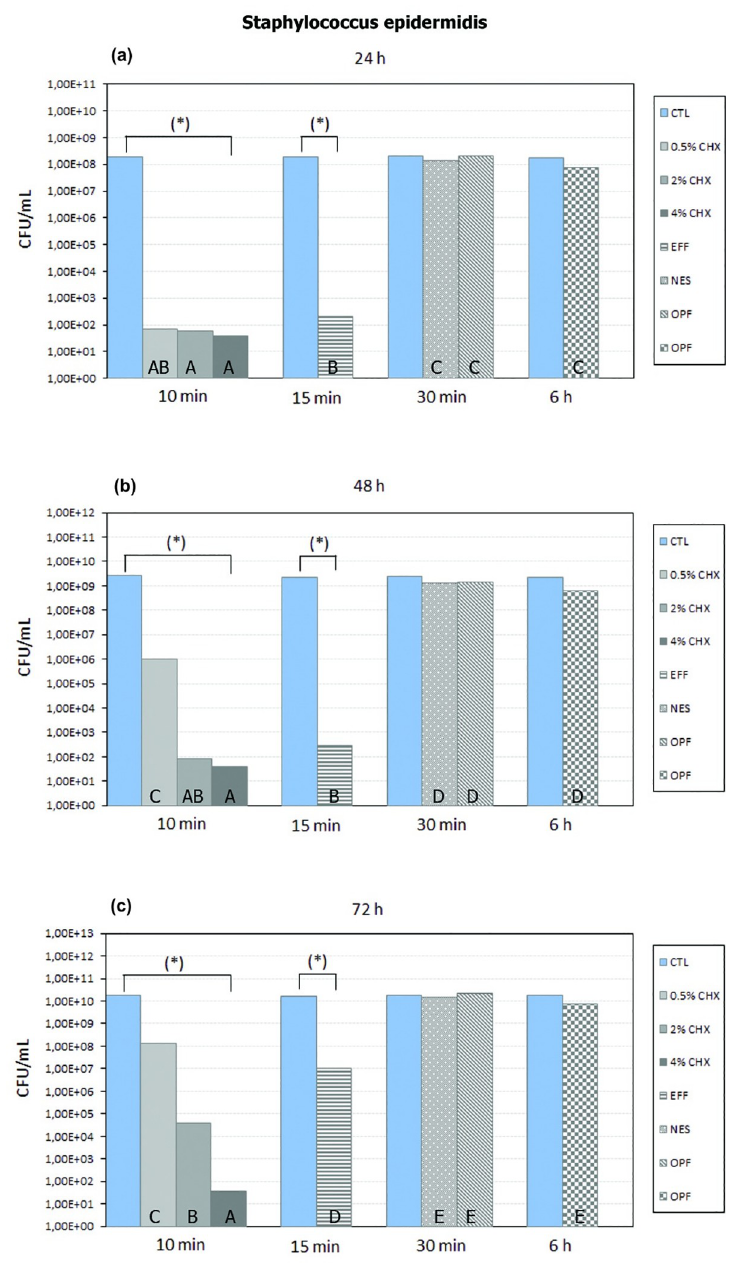
Fig 2. Tukey-Kramer HSD test with a level of significance of 5%. Mean (number of CFU/mL of Staphylococcus epidermidis ) of each control group and each disinfectant group in 24 h (a), 48 h (b) and 72 h (c) of biofilm development. For a comparison only between control group and disinfectant group in each biofilm development period (individually), � means that there is a statistical difference between control group and disinfectant group ( P < 0.05). For a comparison only between disinfectant groups in each biofilm development period (individually), different letters represent a statistically significant difference ( P <